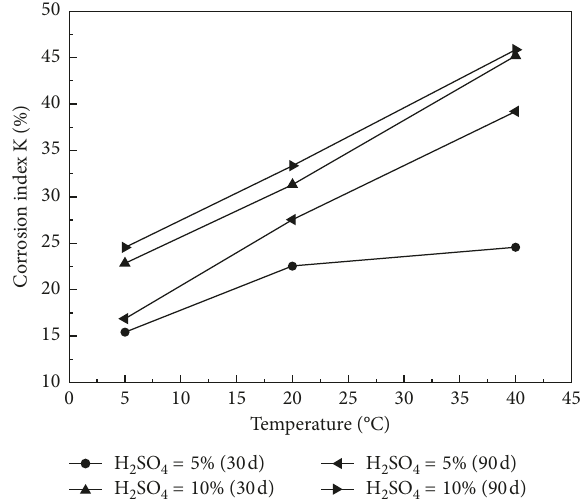
Figure 5: Variation of K -value with tested